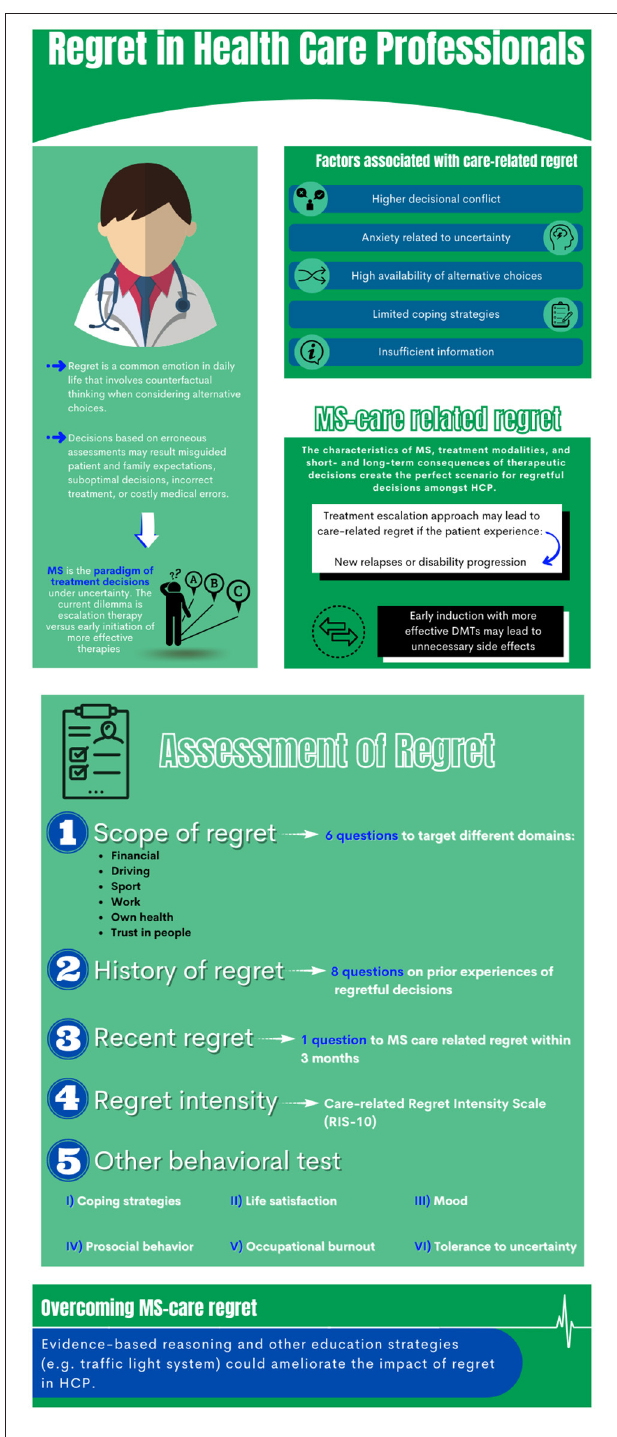
FIGURE 1 | Regret in